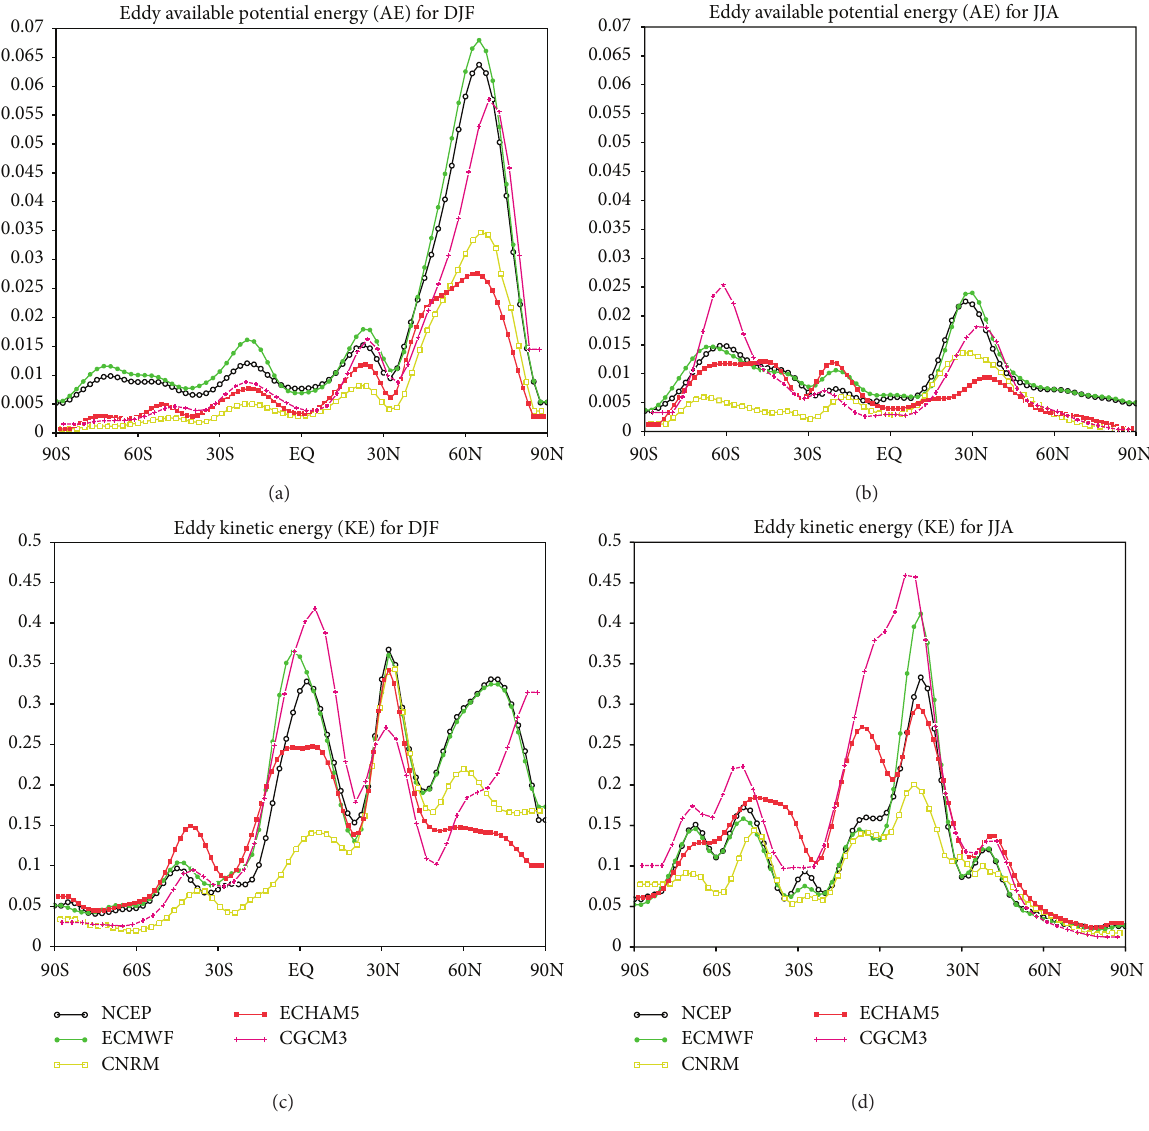
Figure 4: Latitudinal distribution of volume integrated conversion between AZ and KZ (CZ) for DJF (a) and JJA (b), conversion between AZ and AE (CA) for DJF (c) and JJA (d), conversion between AE and KE (CE) for DJF (e) and JJA (f), and conversion between KE and KZ (CK) for DJF (g) and JJA (h) averaged for the period from 1979 to 1999. Units are Wm −2